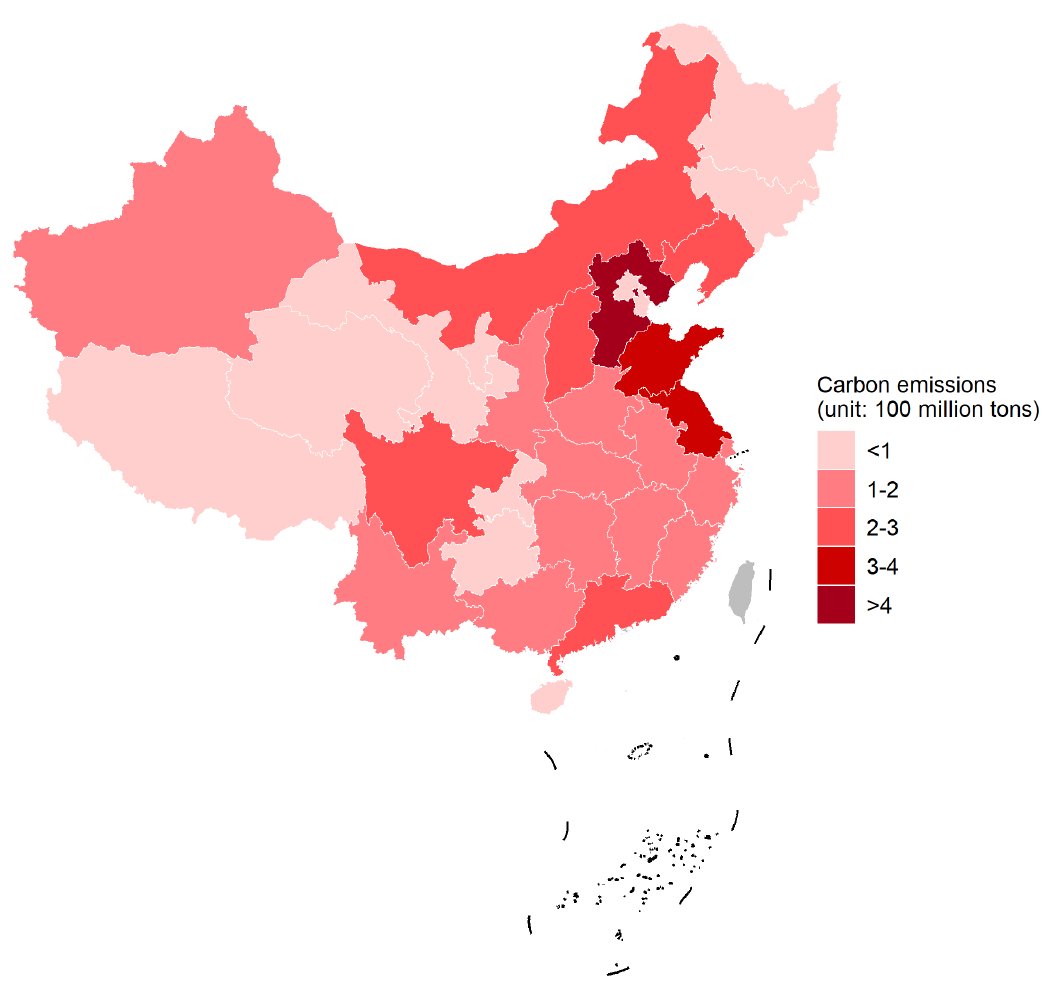
Figure 1. The industrial carbon emissions in the year 2021.